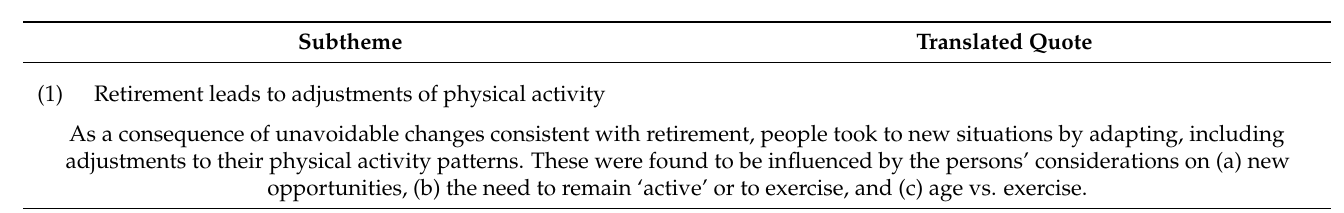
Table 5. Subthemes of theme two, ‘the retirement plan is influenced by the transition’, with supporting